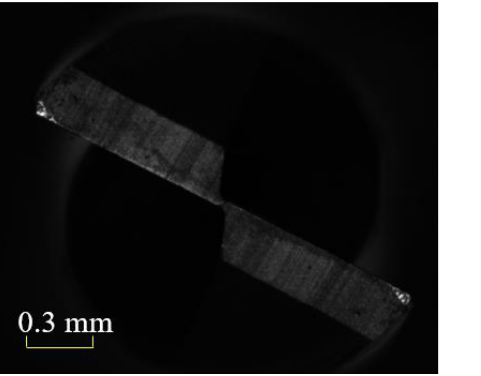
Figure 12. Tool monitoring results.